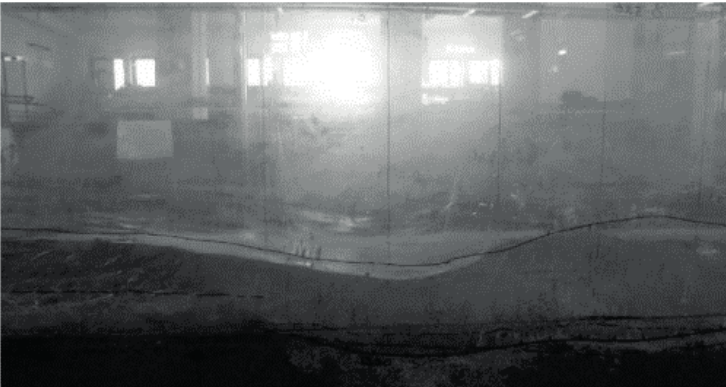
Fig. 6 Photo of the channel reach downstream of the vegetated reach.